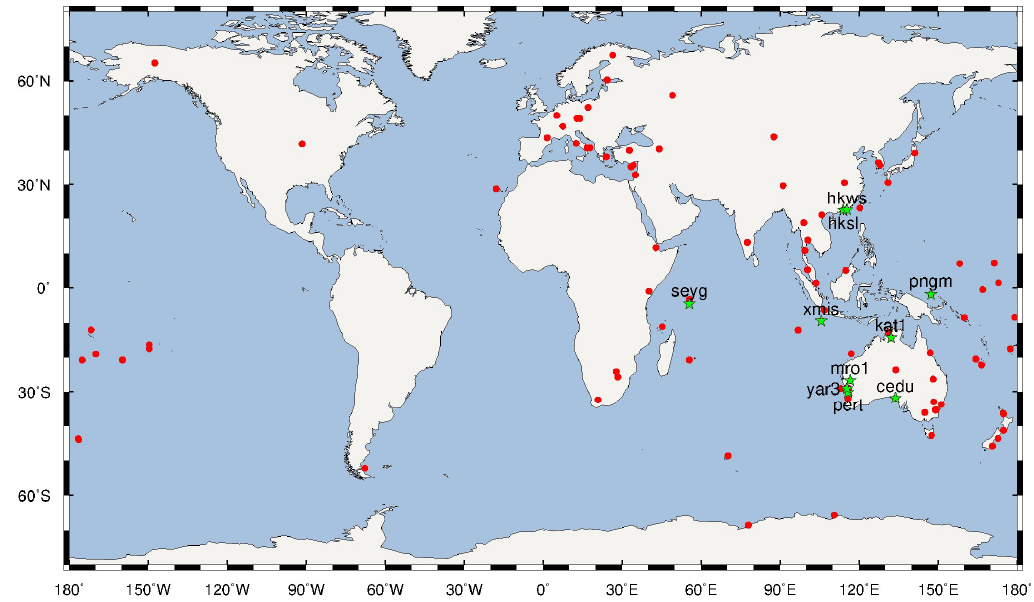
Figure 8. Distribution of MGEX network stations to calculate BDS FCB. The green stars represent the station selected to evaluate the accuracy.